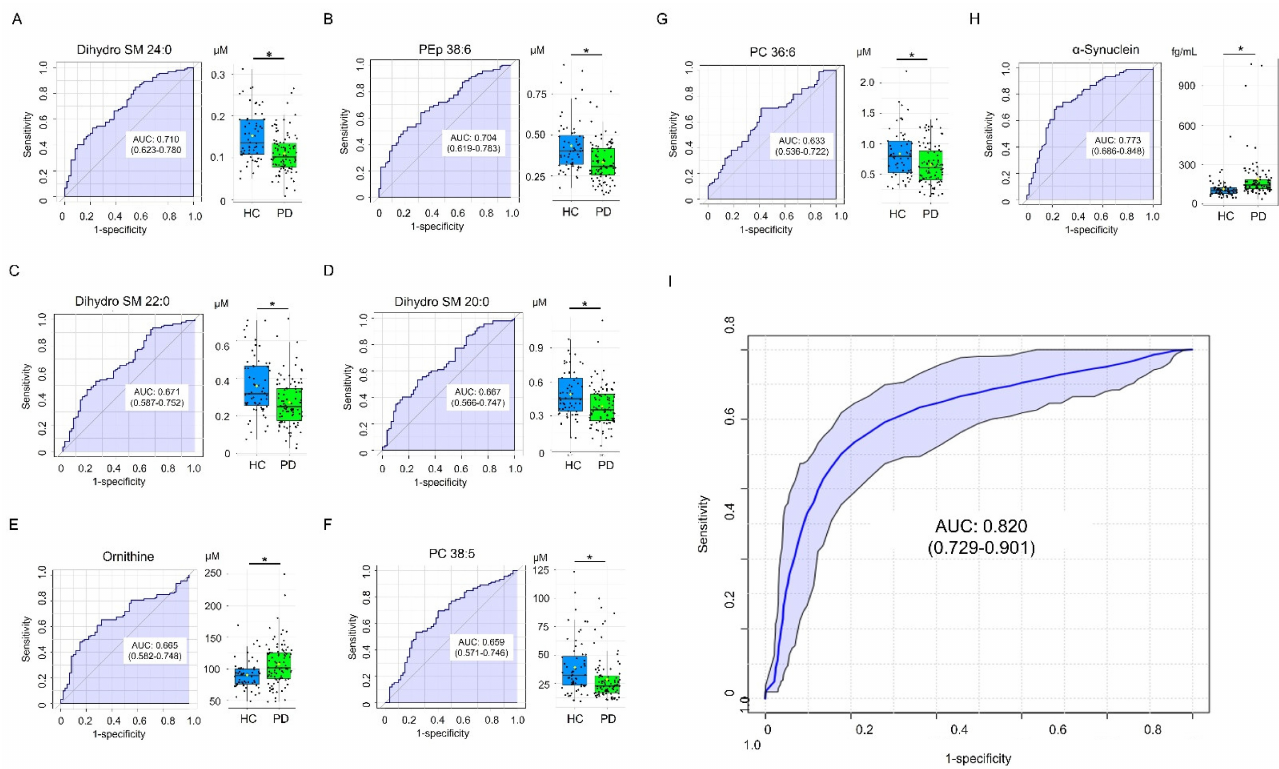
Figure 4. Diagnosis of PD using candidate metabolite markers. Receiver operating character- istic (ROC) curves and box plots for plasma levels of ( A ) dihydro sphingomyelin (SM) 24:0, ( B ) phosphatidylethanolamine-plasmalogen (PEp) 38:6, ( C ) dihydro SM 22:0, ( D ) dihydro SM 20:0, ( E ) ornithine, ( F ) phosphatidylcholine (PC) 38:5, ( G ) PC 36:6, and ( H ) α -synuclein for the diagnosis of Parkinson’s disease (PD). The area under the ROC curve (AUC) was in shadow. The black center line in box plots denoted the median, while the blue or green boxes contain the 25th to 75th percentiles. The black whiskers mark the 5th and 95th percentiles, and mean values were marked with yellow dots. *: Statistically significant between PD and the healthy controls (HC), p < 0.05, Two-tailed Student’s t -test. ( I ) ROC analysis on a combination of α -synuclein, dihydro SM 24:0, and PEp 38:6 by support vector machine. The 95% confidence band was in